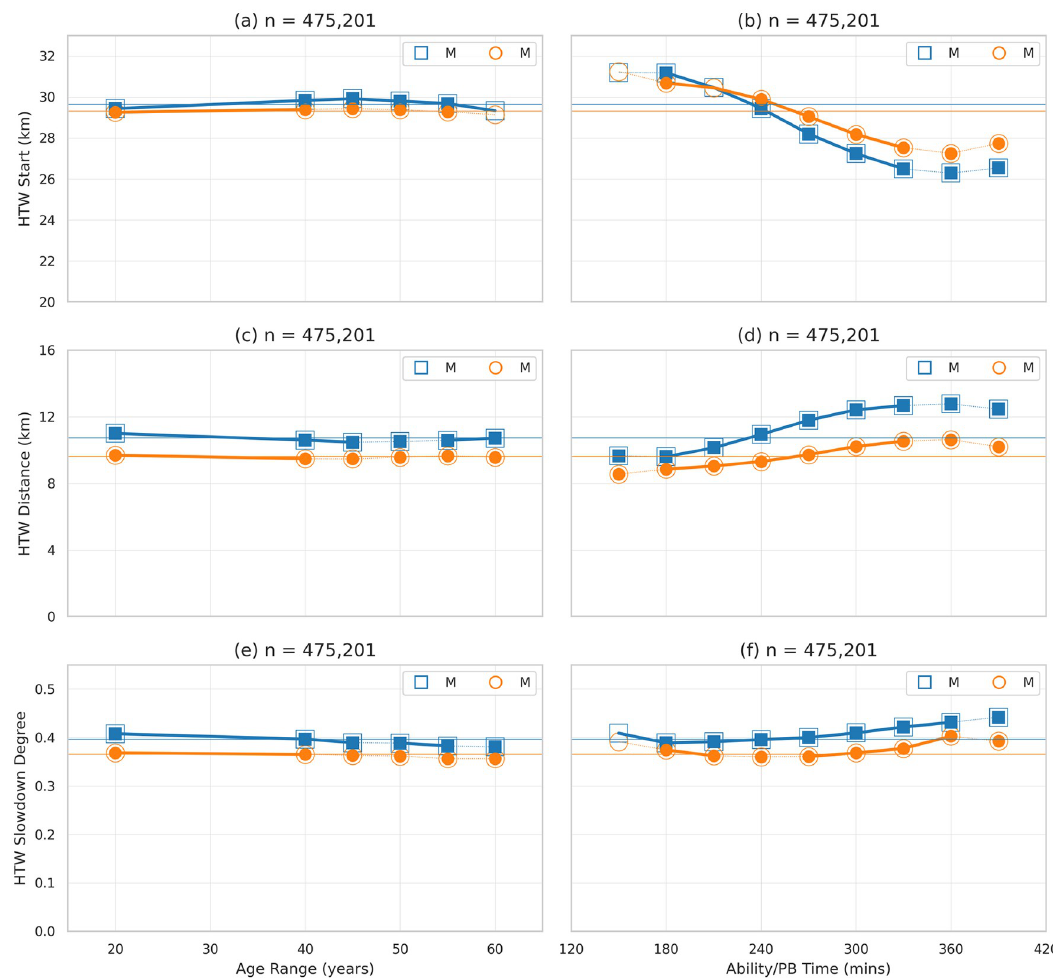
Fig 5. HTW dimensions (start, distance, slowdown) for male and female runners by age range and ability. HTW Start refers to the average distance at which runners begin the slowdown that corresponds to their hitting the wall. HTW Distance refers to the length of this slowdown and HTW Slowdown refers to the degree of this slowdown, relative to their base-pace (that is, their average pace during the 5–20km portion of the